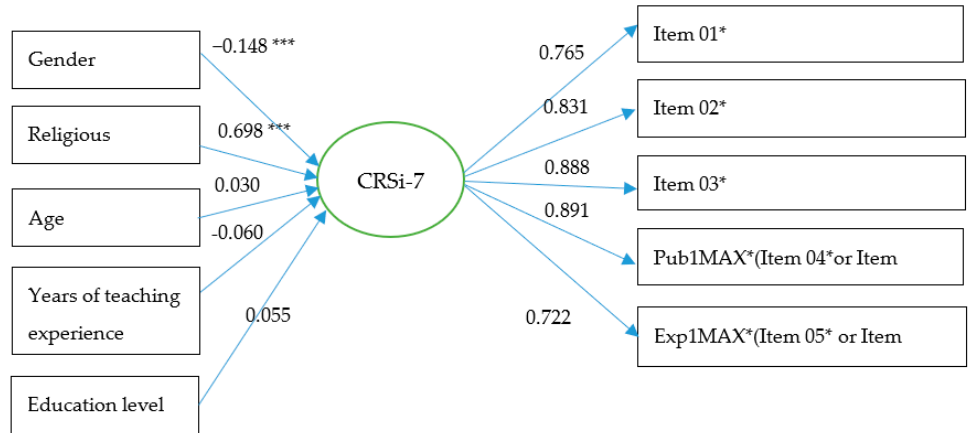
Figure A2. MIMIC model for CRSi-7; * Item 01 to Item 05 refer to Item 01-05 in Appendix C; *** p < 0.001; Pub1MAX*: The participants answered Item 04(How often do you pray?) and 04b (How often do you meditate?). However, only one answer is counted in the calculation of the score of the CRS, which indicated a higher frequency; Exp1MAX*: The participants answered Item 05(How often do you experience situations in which you have the feeling that God or something divine intervenes in your life?) and 05b (How often do you experience situations in which you have the feeling that you are in one with all?). However, only one answer is counted in the calculation of the score of the CRS, which indicated a higher